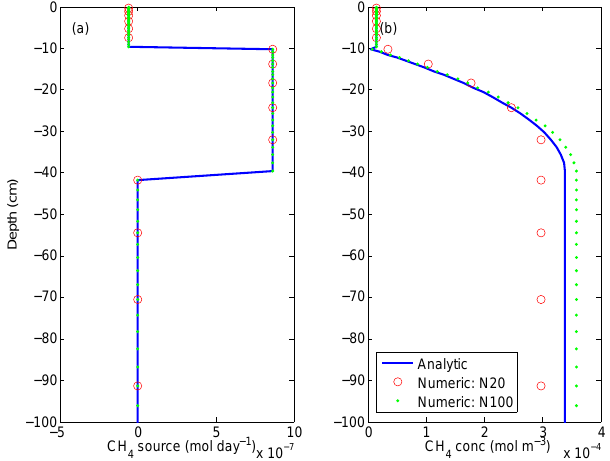
Figure 3. Comparison between the numerical and analytical solu- tions for the steady-state soil methane model: (a) net CH 4 source profiles and (b) soil gaseous CH 4 profiles. N20 indicates the so- lution using 20 numerical layers and N100 indicates the solution using 100 numerical layers.